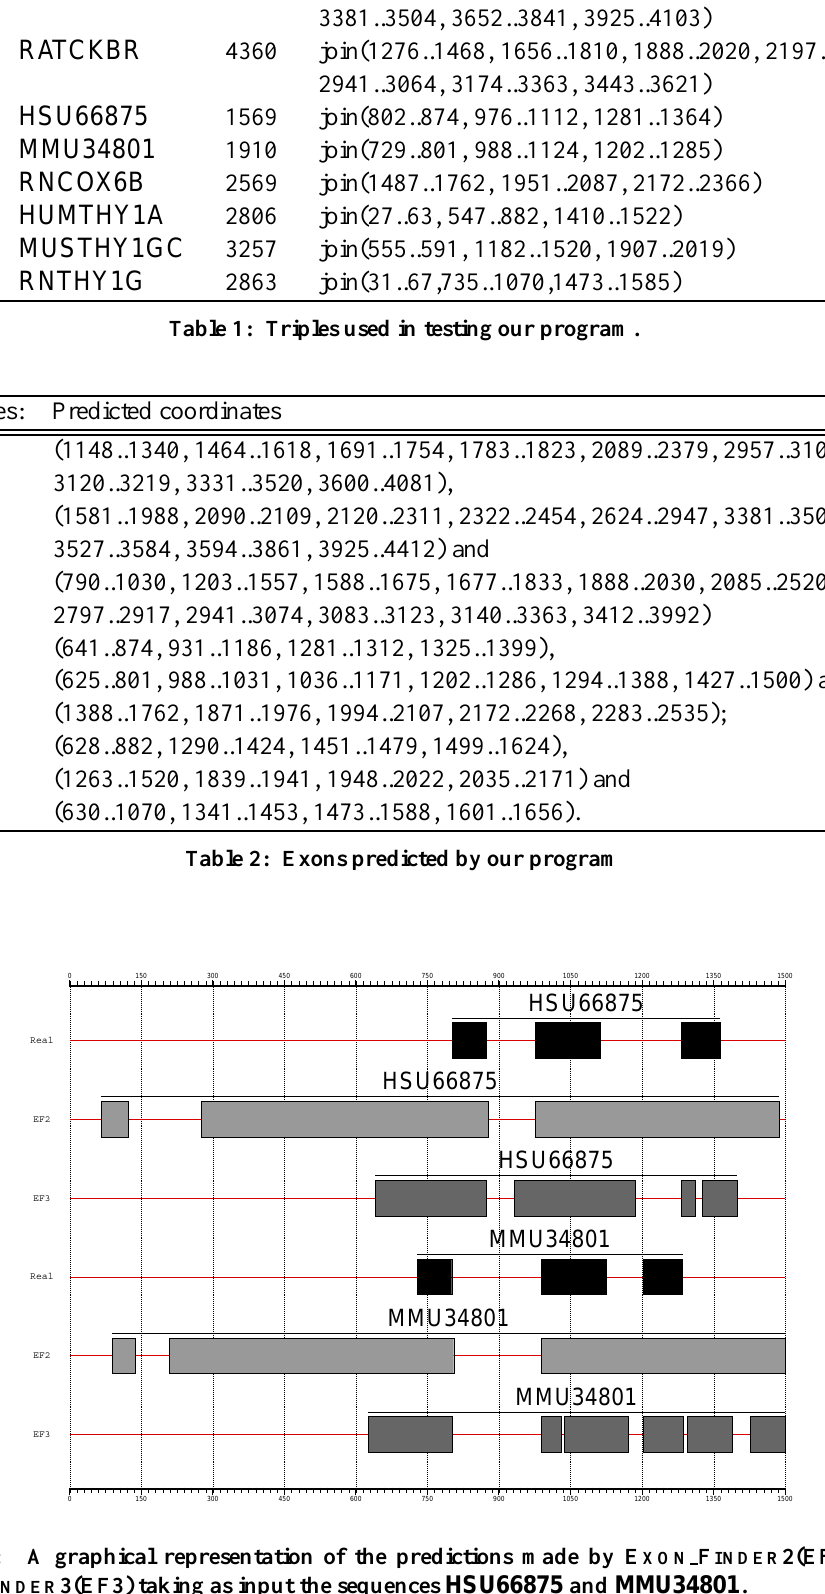
Figure 3: A graphical representation of the predictions made by E XON F INDER 2(EF2) and E XON F INDER 3(EF3) taking as input the sequences HSU66875 and MMU34801 .